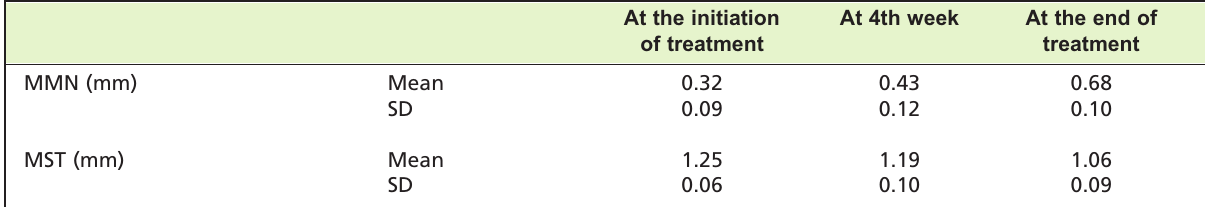
Mean medial malleolar navicular (MMN) distance and mean medial soft tissue thickness (MST) Table II: